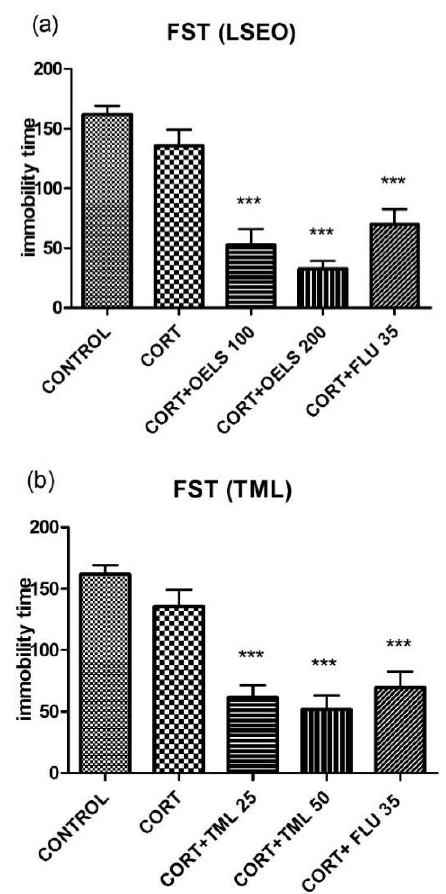
Figure 3. Effects of repeated administration of ( a ) LSEO (100 and 200 mg/kg; p.o.) and ( b ) TML (25 and 50 mg/kg; p.o.) in animals treated with CORT (22 days, 20 mg/kg, s.c.) on the immobility time, in seconds (s), on the FST. Values are expressed as mean ± SEM ( n = 10). Statistical analysis was determined by one-way ANOVA followed by the Student-Newman-Keuls test. Significant values: *** p < 0.0001 vs. CORT. LSEO Lippia sidoides essential oil; TML = thymol; CORT = corticosterone; FST = forced swimming test.